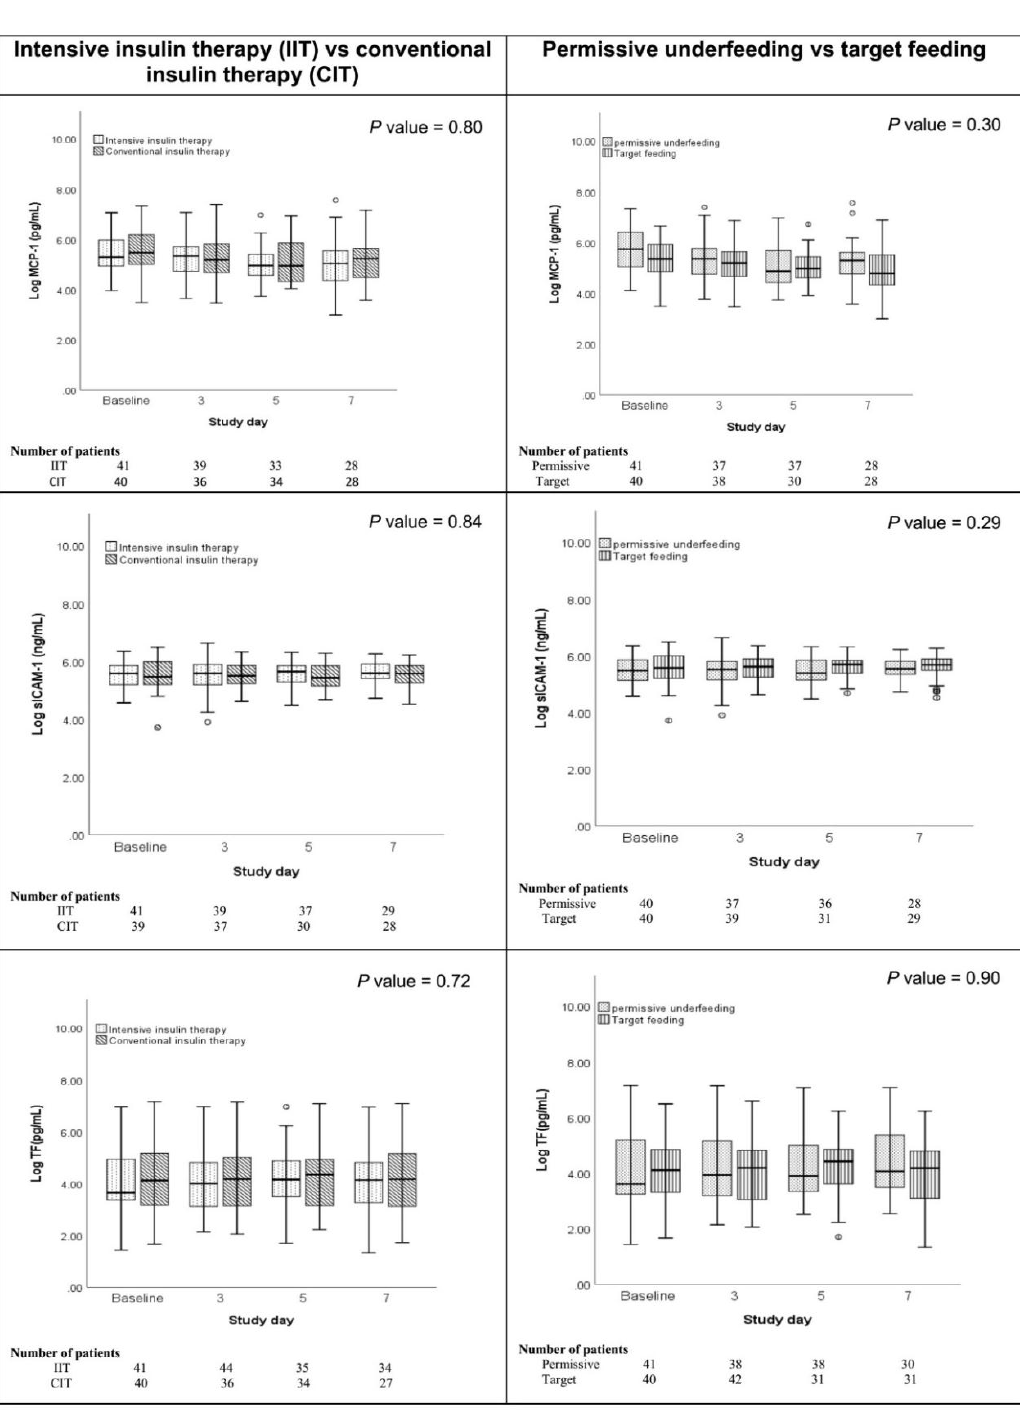
Figure 1. Plasma TF, MCP-1 and sICAM-1 by randomization group at each point of time expressed as box plots. Results are presented as Log.